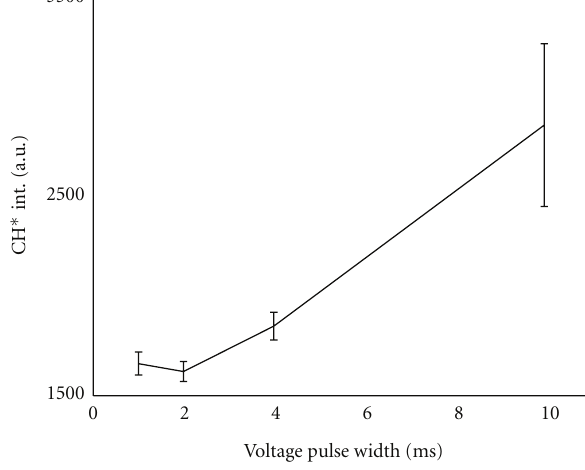
Figure 6: Plot of intensity fluctuations of a reaction zone as a function of the applied voltage pulse width. With +2.7kV applied voltage and increasing pulse width, the CH (A-X) chemilumines- cence intensity fluctuation becomes increasingly larger suggesting that reaction zones become more mobile, indicating a transition from laminar flow to